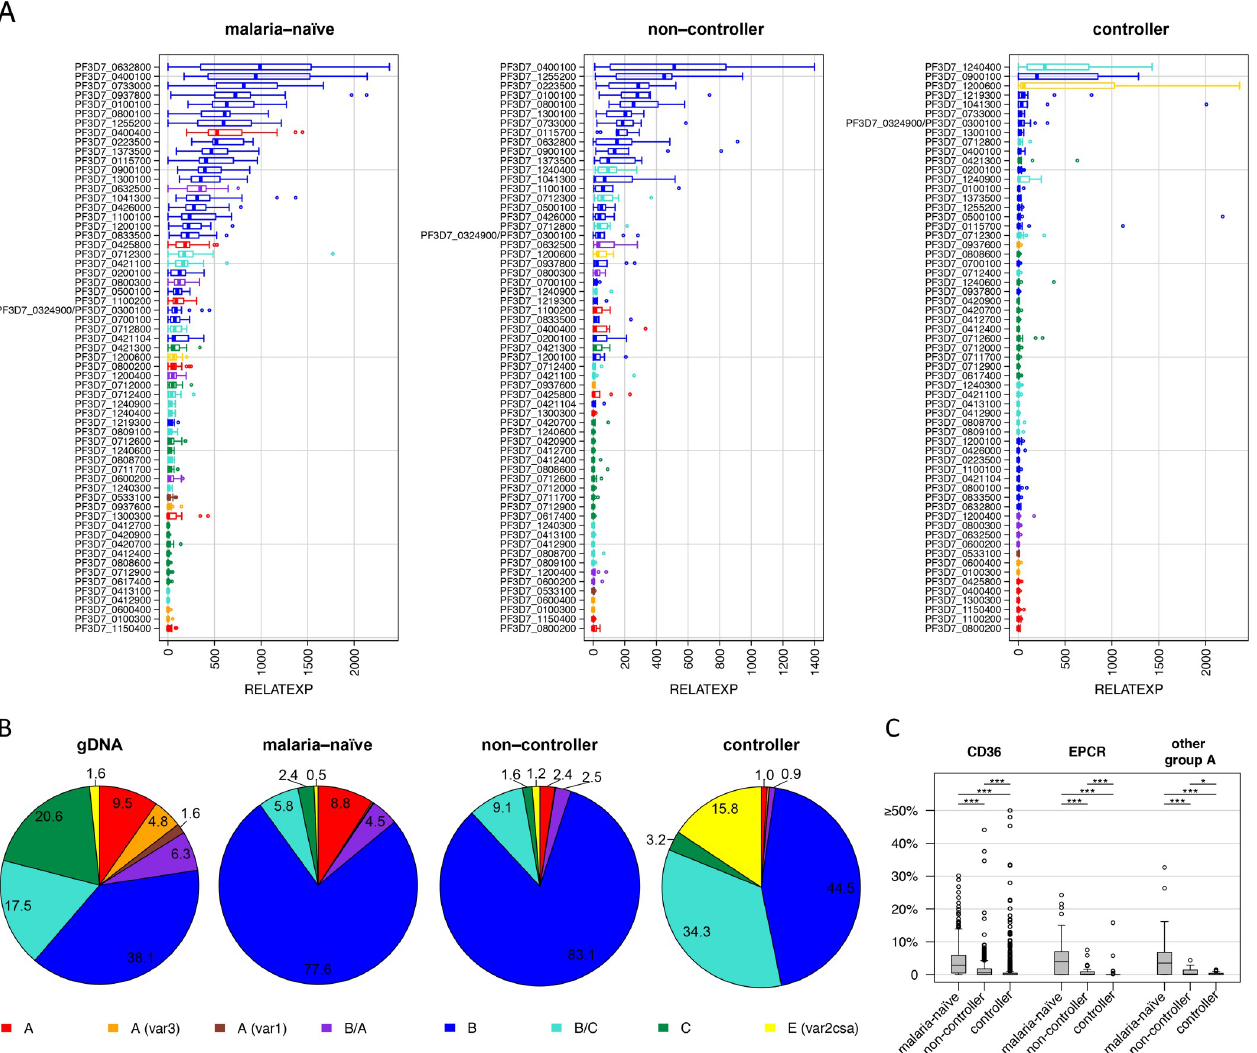
Fig 3. Impact of semi-immunity on parasites’ var gene expression. (A) Ranking of var genes according to transcript level detected in samples from malaria- na ï ve volunteers and lifelong malaria-exposed adults classified as ‘non-controller’ and ‘controller’ at the last time point sampled prior to treatment. The median var transcript level relative to the sbp1 transcript level with IQR is shown for all malaria-na ï ve (n = 18), ‘non-controller’ (n = 5) and ‘controller’ (n = 5) volunteer samples. Expression values for genes of the different var groups are presented in red (group A), orange (subfamily var3 ), dark red (subfamily var1 ), purple (group B/A), blue (group B), turquoise (group B/C), green (group C) and yellow (group E). (B) Proportion of var transcripts according to var group affiliation in parasites from malaria-na ï ve, ‘non-controller’ & ‘controller’. For comparison, genomic proportions of genes classified into the different var gene groups are shown. Proportions of var3 and var1 type gene expression are not indicated separately, because numbers were below 0.3% in all volunteer groups. (C) Comparison of the levels of var transcripts encoding for EPCR-binding CIDR α 1 (‘EPCR’), CD36-binding CIDR α 2–6 (‘CD36’) or CIDR γ / δ (‘other group A’) domains in the different volunteer groups. Shown are expression values (%) for each var gene normalized against total var transcript level in each volunteer sample and plotted showing the median and the IQR. Gene expression of the different gene sets varied significantly between volunteer groups (Mann Whitney U test, � = p < 0.05, �� = p < 0.01, ��� = p <